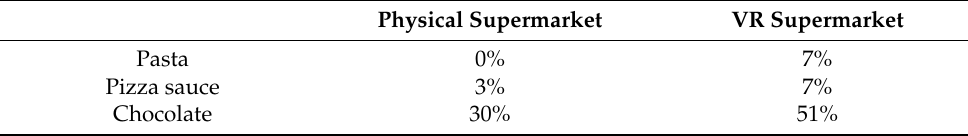
Table 1. Percentages of participants’ ability to recall the actual price for each product